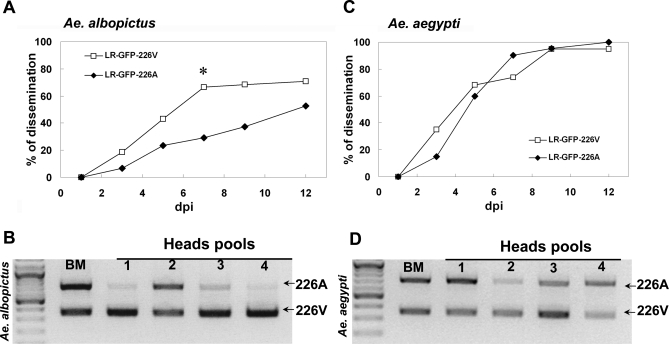
Effect of E1-A226V Mutation on CHIKV Dissemination into Salivary Glands and Heads of Ae. albopictus and Ae. aegypti Mosquitoes
Ae. albopictus (A) and Ae. aegypti (C) mosquitoes were orally infected with LR-GFP-226V and LR-GFP-226A. At the indicated time points, 16–21 mosquitoes were dissected and salivary glands were analyzed for eGFP expression. Percent of dissemination was estimated as a ratio of the number of mosquitoes with eGFP-positive salivary glands to the number of mosquitoes with eGFP-positive midguts. For Ae. albopictus, infectious blood meal titers were 5.95 and 6.52 Log10TCID50/ml for LR-GFP-226V and LR-GFP-226A, respectively. For Ae. aegypti, the infectious blood meal titer was 6.95 Log10TCID50/ml for both LR-GFP-226V and LR-GFP-226A viruses. Dissemination rates were compared statistically by Fisher's exact test using SPSS version 11.5. Asterisk indicates p < 0.05.(B and D) Competition between LR-ApaI-226V and LR-226A for dissemination into heads of Ae. albopictus and Ae. aegypti mosquitoes. 107 pfu of LR-ApaI-226V and LR-226A were mixed and orally presented to Ae. albopictus (B) and Ae. aegypti (D). Viral RNAs were extracted from four pools of five heads collected at 12 dpi. RT-PCR products were digested with ApaI, separated in 2% agarose gel, and gels were stained using ethidium bromide.BM - initial ratio of LR-ApaI-226V and LR-226A in blood meal samples. 1–4 ratio of LR-ApaI-226V and LR-226A RNA in four independent replicas of the five pooled heads per replica.